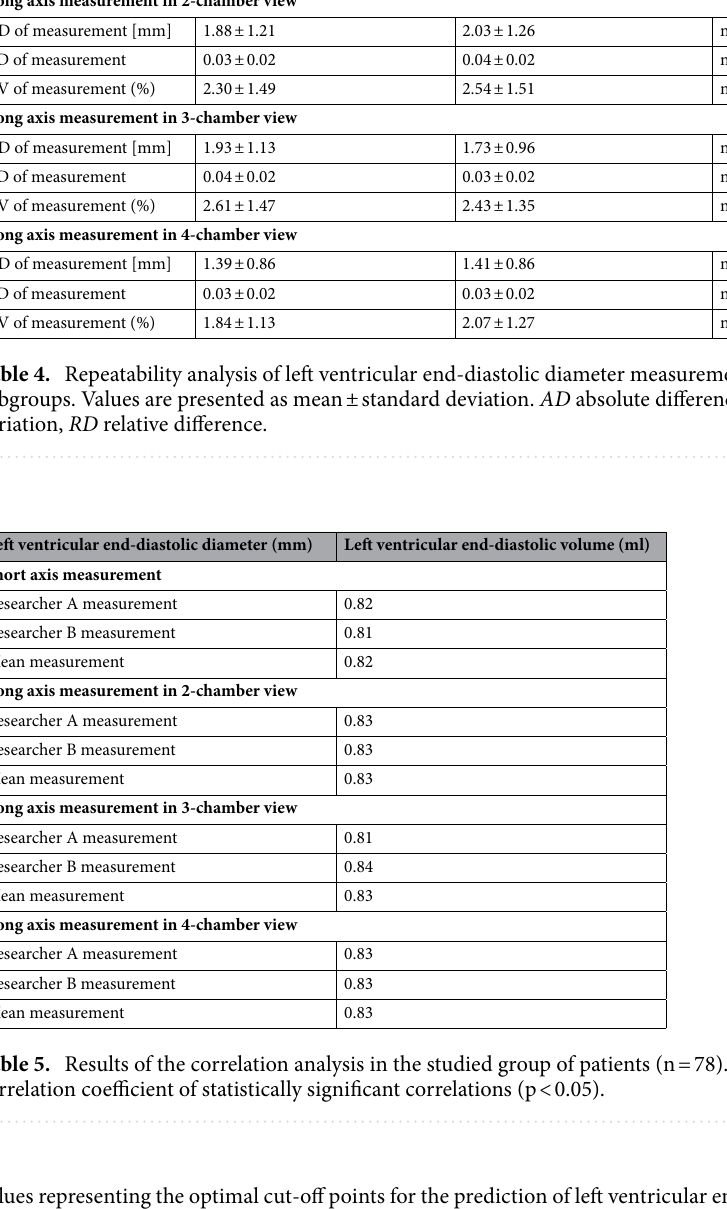
values representing the optimal cut-off points for the prediction of left ventricular enlargement in the male sub- group (Fig. 2A–D) and in the female subgroup (Fig. 3A–D) were determined based on successive ROC curves. In the male subgroup, the highest accuracy in predicting left ventricular enlargement was characterized by the criterion “LVEDD measured in the long axis in the 2-chamber view > 68.0 mm”. The accuracy for this criterion was 94.1%. The accuracy of the other predictors ranged from 88.2 to 92.2%. In the female subgroup, the highest accuracy in predicting left ventricular enlargement was achieved by the criterion “LVEDD measured in the short axis > 63.5 mm”. The accuracy of this criterion was 96.3%. For the remaining predictors, the accuracy ranged from 48.1 to 88.9%. Table 6 summarizes the overall results of the sensitivity and specificity analysis on the prediction of left ventricular enlargement based on the LVEDD measured in CMR.